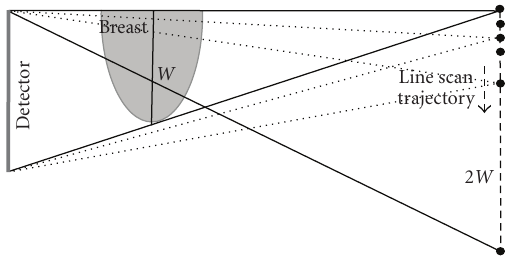
Figure 3: Illustration of the straight line scan to achieve exact reconstruction.